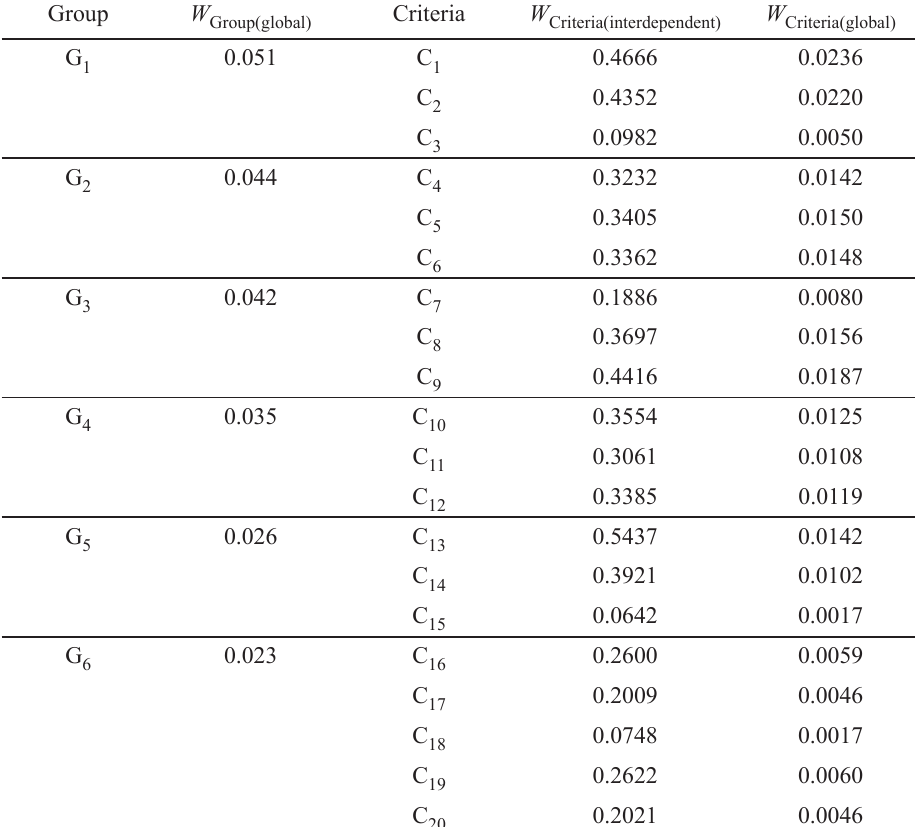
Table 14. The computed results for all